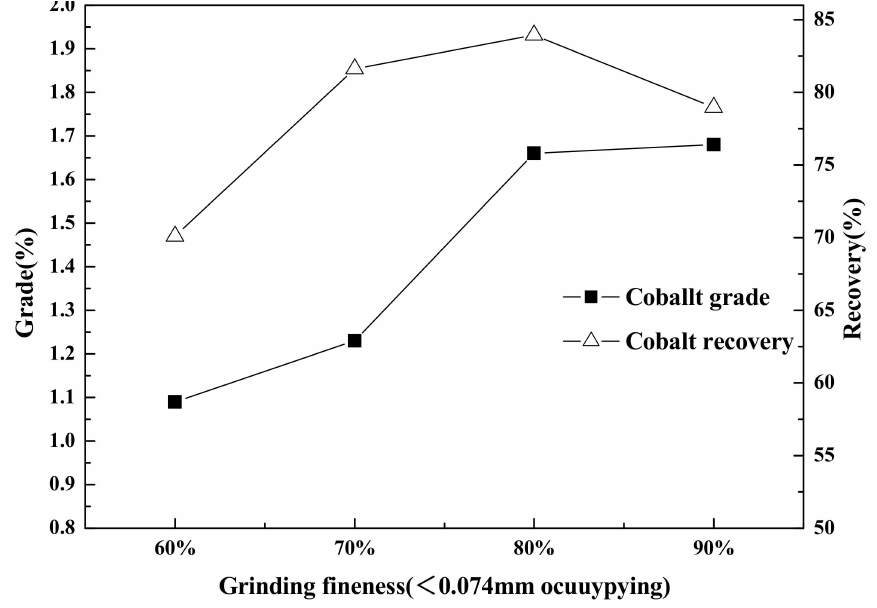
Figure 5. E ff ect of grinding fineness on cobalt grade and recovery in